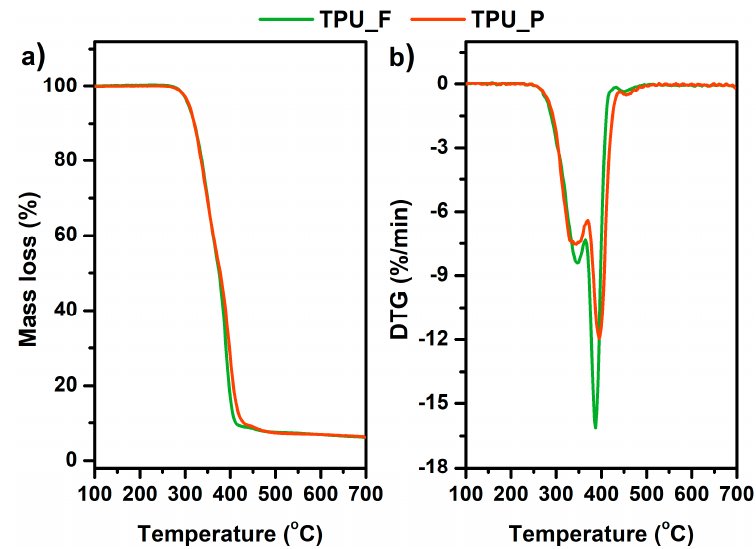
Figure 5. Mass loss ( a ) and derivative thermogravimetric DTG curves ( b ) vs. temperature of TPU filament and printout.